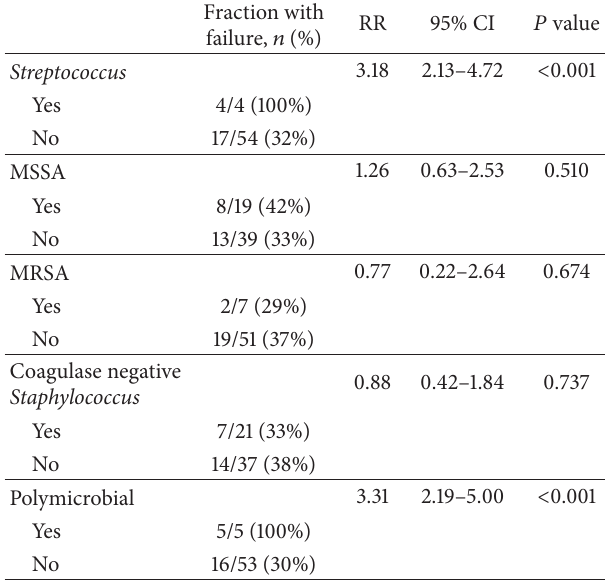
Table 4: Risk factors for failure: